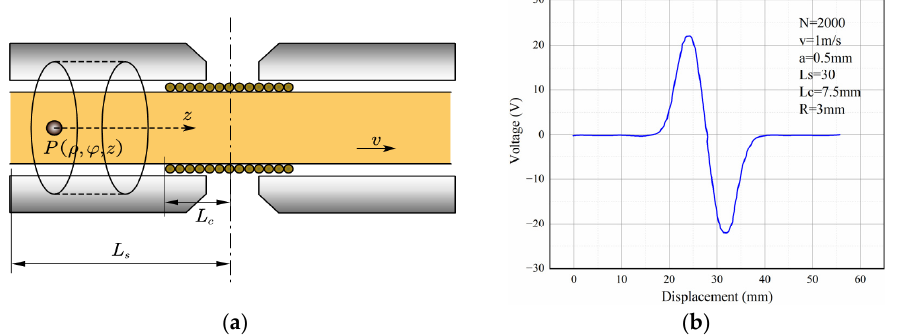
Figure 4. Mathematical model: ( a ) coordinate system when debris moving in the sensor; ( b ) induced voltage.